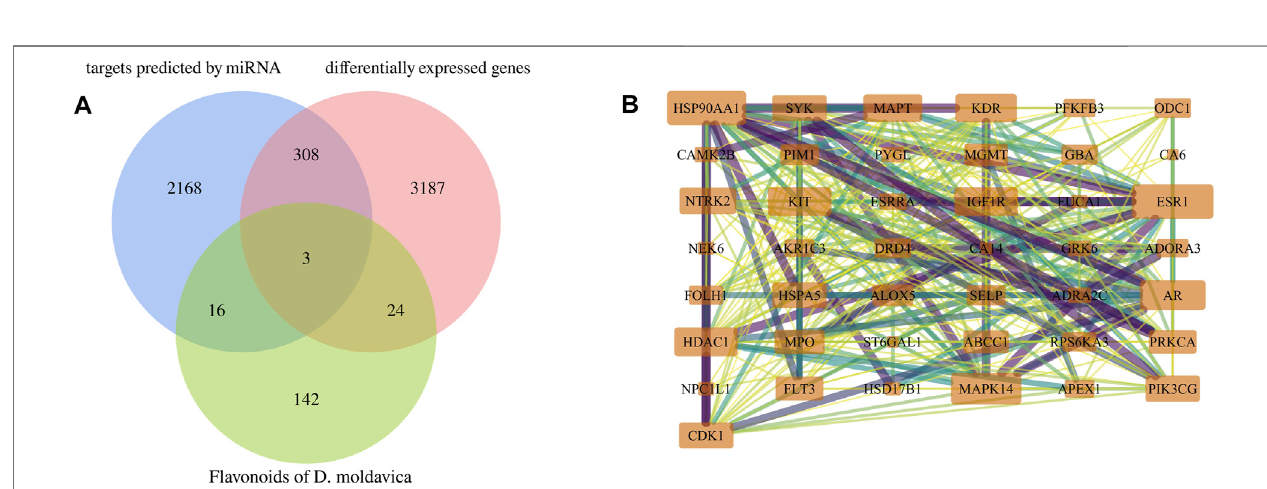
Frontiers in Pharmacology |